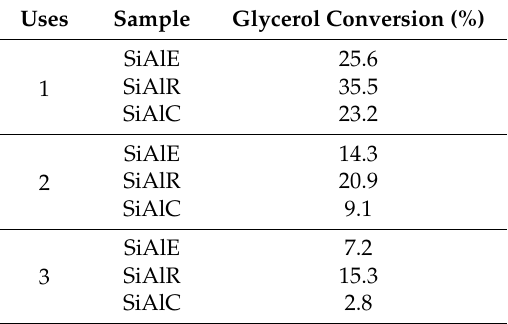
Table 3. Recyclability studies of the solids. Reaction conditions were as follows: 75 mg of catalyst, mentioned conditions, the solids were reused for 6 h for each cycle. Uses Sample Glycerol Conversion